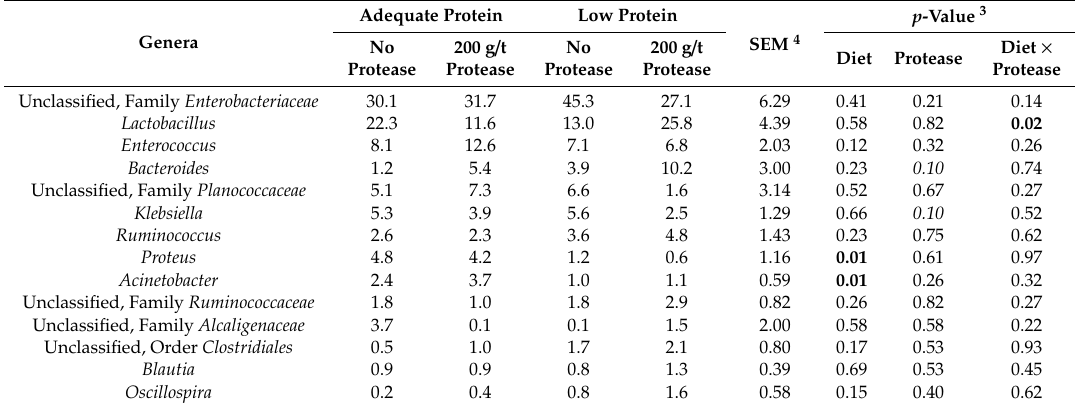
Table 6. E ff ect of diet 1 and protease on relative abundance (%) of the main bacterial genera 2 . Genera